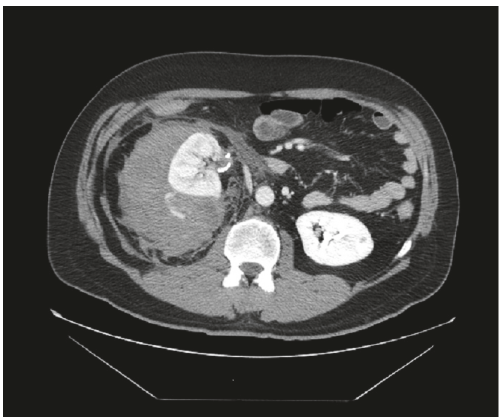
Figure 1: Active contrast extravasation from the right kidney on computed tomography.